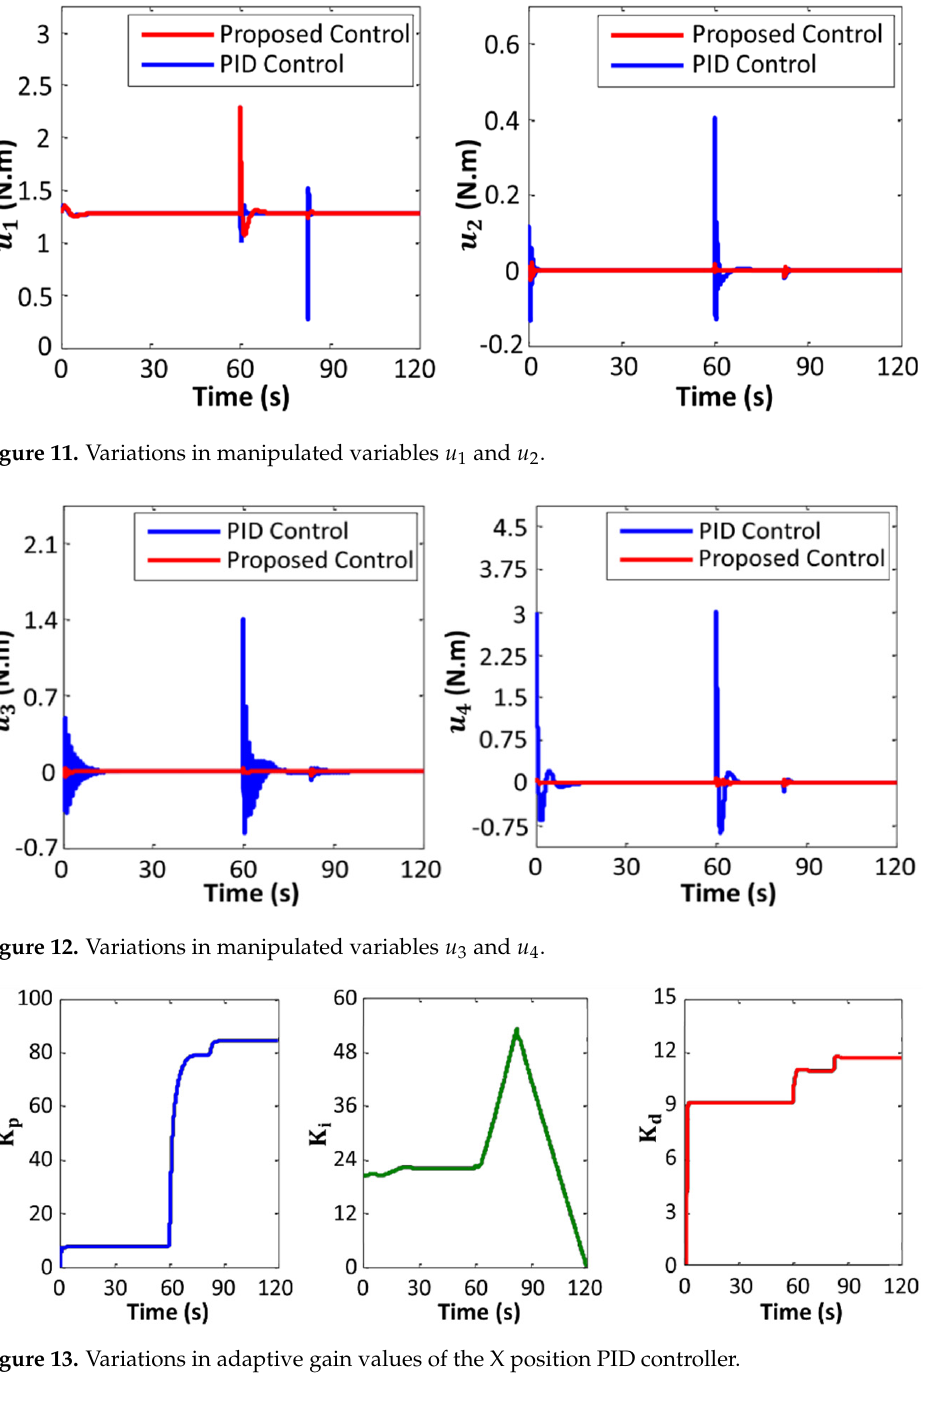
Figure 10. Performance of the quadcopter in tracking the desired Roll and Pitch angles.